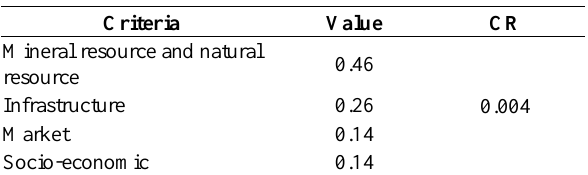
Table 6. Weights of factors influencing for metallurgical and steel processing industry